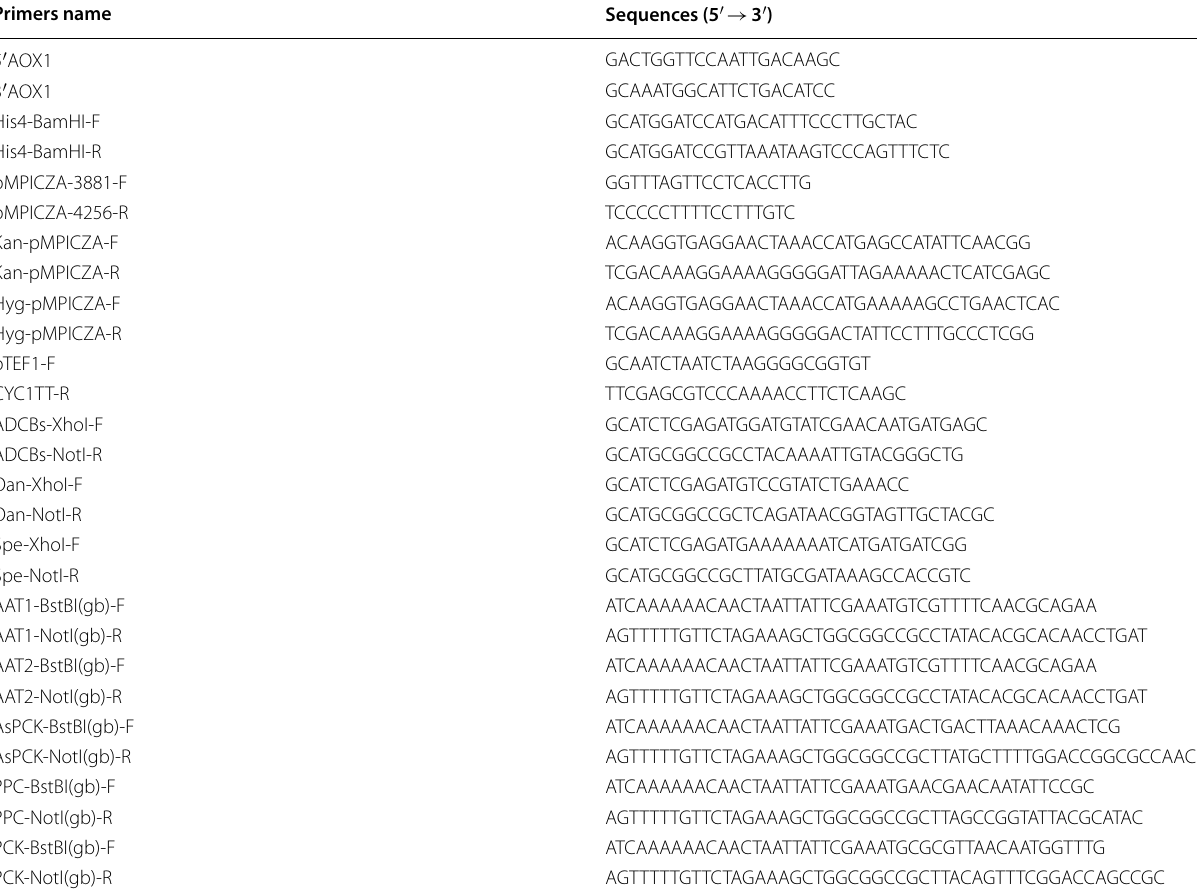
Table 1 Primers used in this